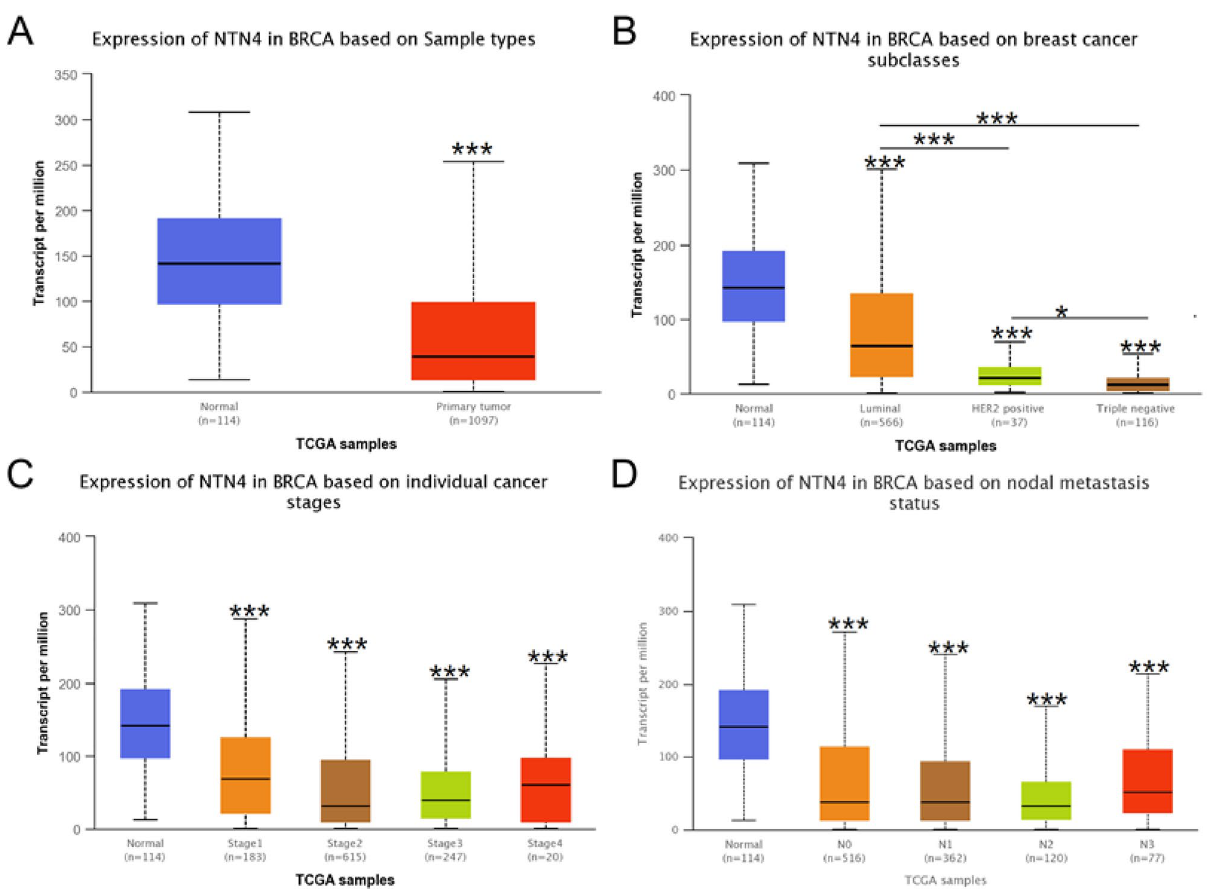
Figure 2. NTN4 mRNA expression in breast cancer based on UALCAN. Expression of NTN4 in breast cancer based on different ( A ) sample types, ( B ) molecular subtypes (in particular TNBC), ( C ) individual clinical stage, ( D ) lymph nodal